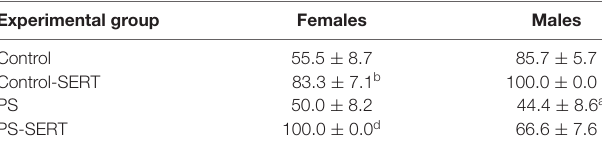
TABLE 1 | Percentage of animals that managed to extinguish fear of the box. Experimental group